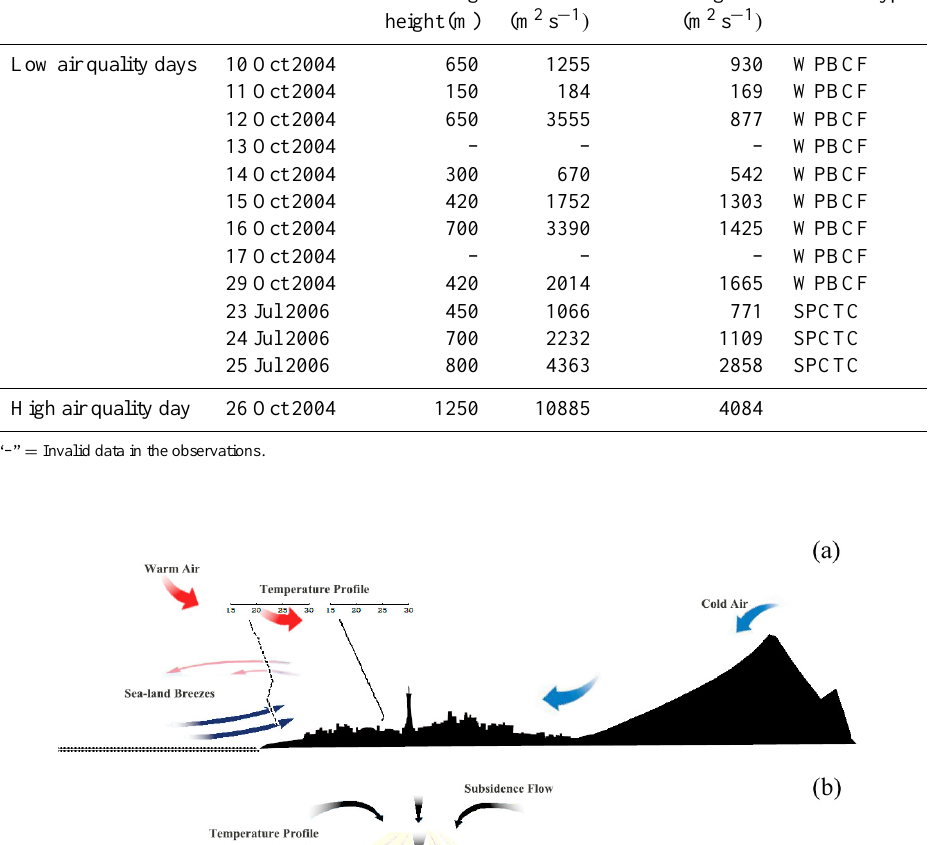
Table 3. Peak mixing height, peak VI, and 24h average VI values during the low air quality and high air quality days. Peak mixing